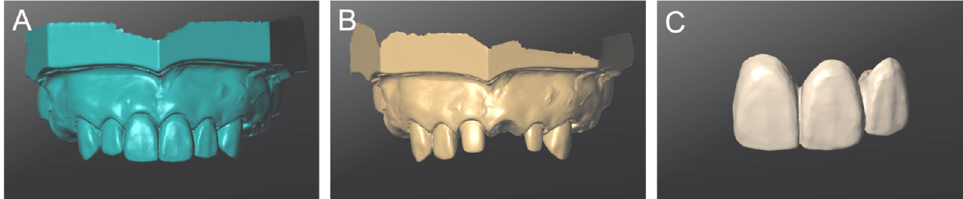
Figure 4. Scan data of cast created by the intra- and extra-oral scanning (IEOS) technique. ( A ) Provisional restoration attached (Data 1). ( B ) Tooth preparation formed model (Data 2). ( C ) Provisional restoration (Data 3).